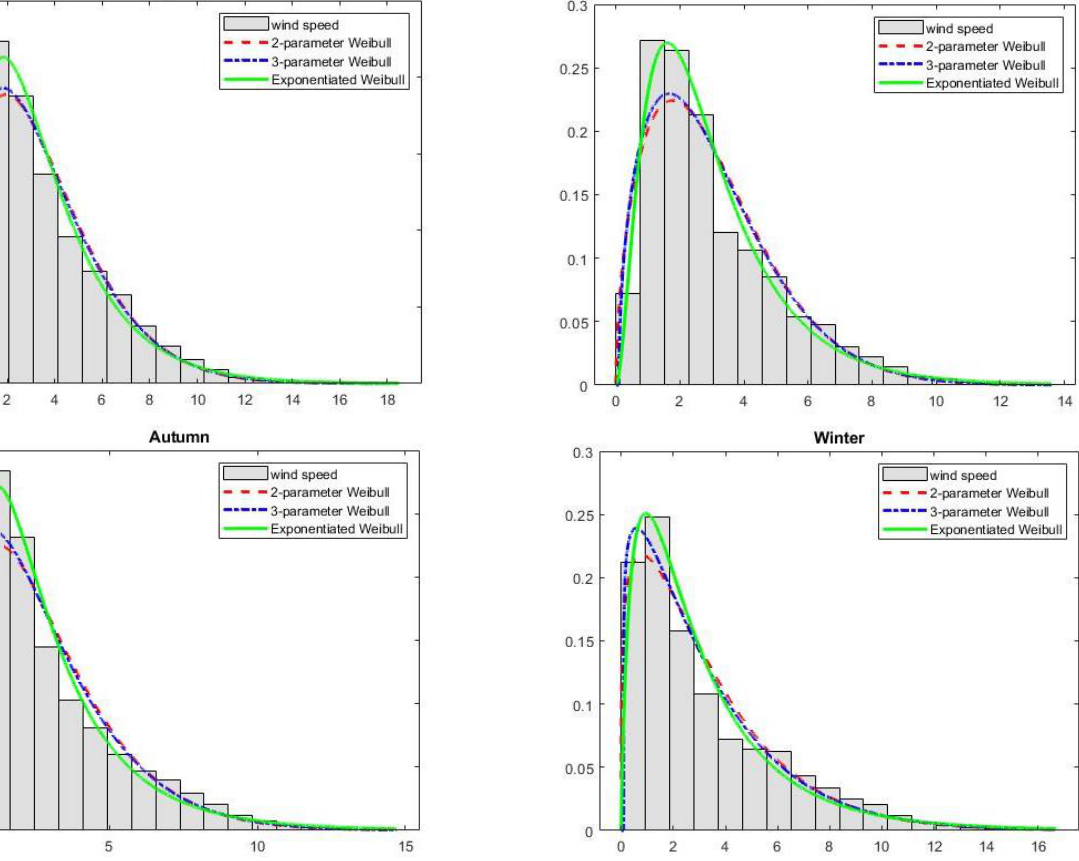
Figure 6. Modelled probability distributions fitted to the histogram of the wind speed data—the seasons.